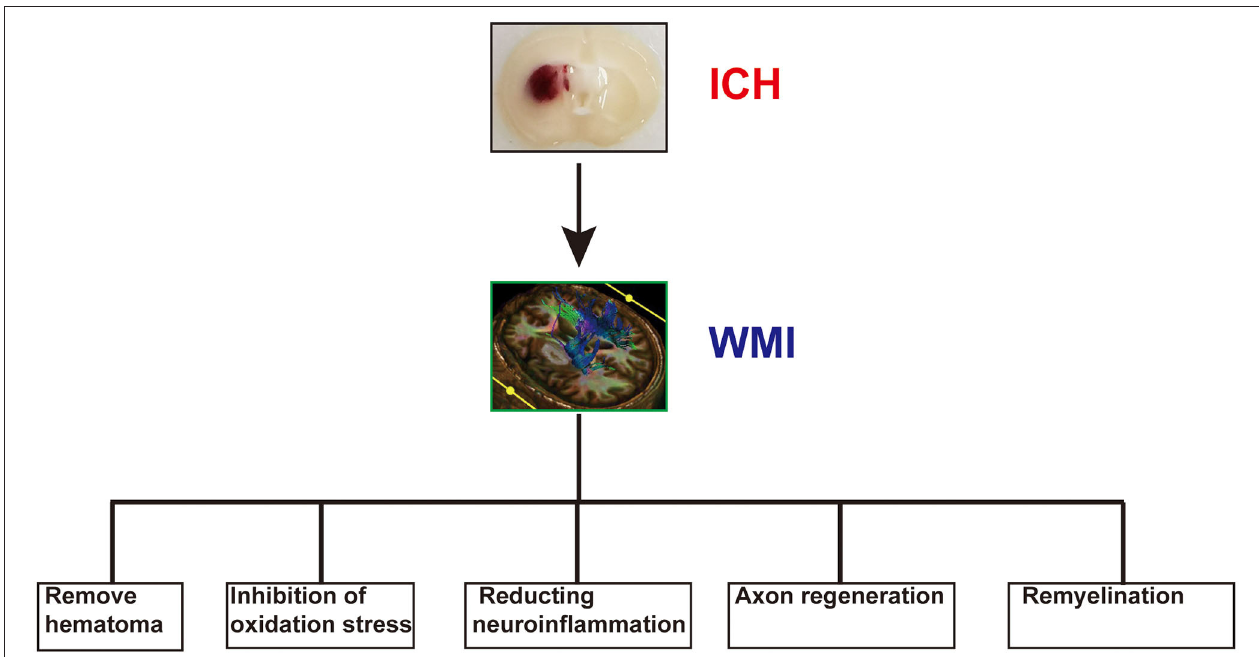
FIGURE 3 | The potential therapeutic strategy of white matter injury (WMI) after intracerebral hemorrhage (ICH).